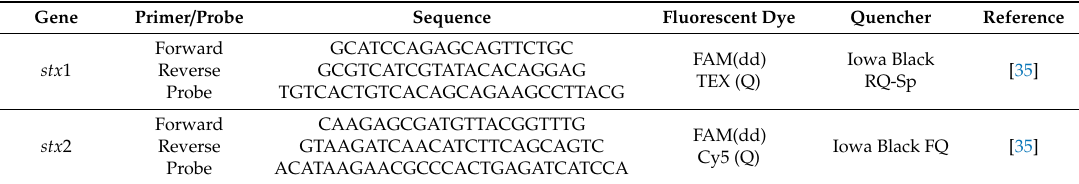
Table 1. Sequences of primer and probes used for four-plex qPCR and duplex ddPCR *.